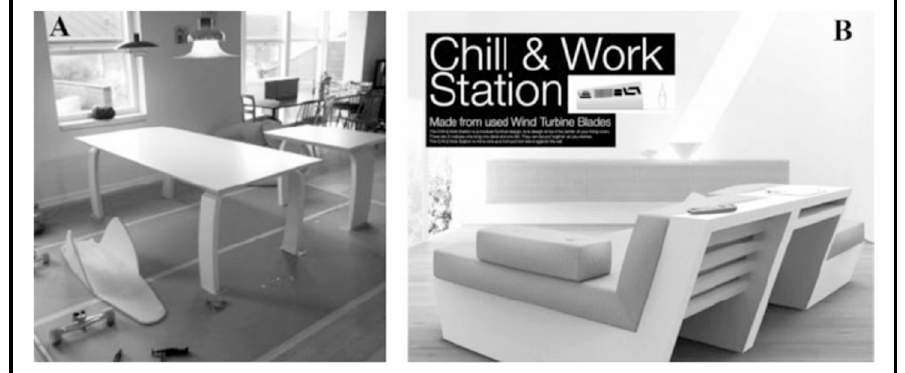
Figure 8. Furniture made from end-of-life wind turbine blades by Wigh Design, ( A ) Table and longboard, ( B ) Prototype of furniture [159].